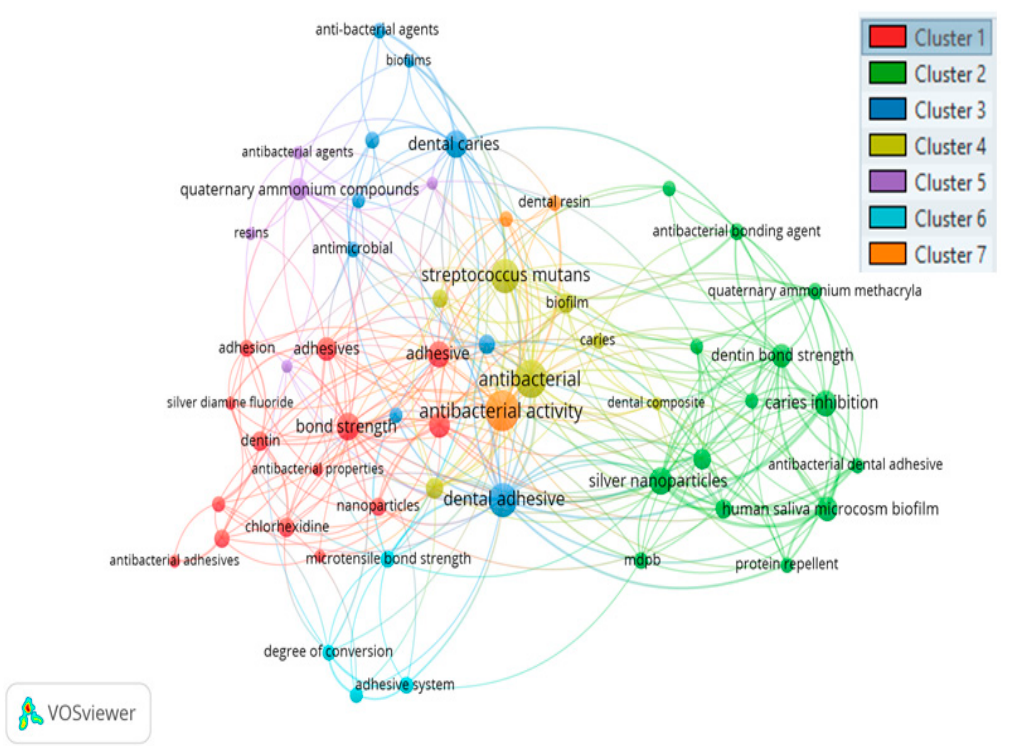
Figure 4. Co-occurrence network of author keywords (minimum number of occurrences: three). A